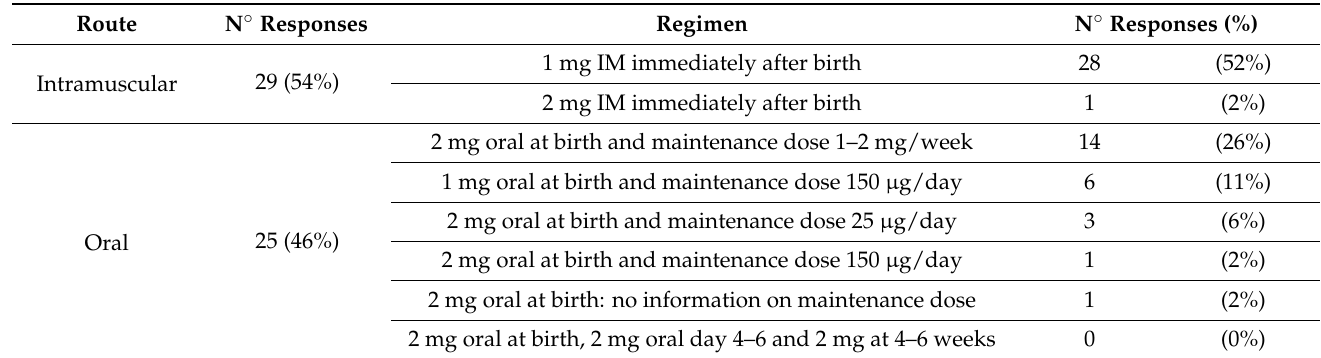
Table 3. Vitamin K prophylaxis for term breastfed infants in Flanders (Reprinted with permission from ref. [49]. Copyright 2021 Belgian Society of Paediatrics.). Route